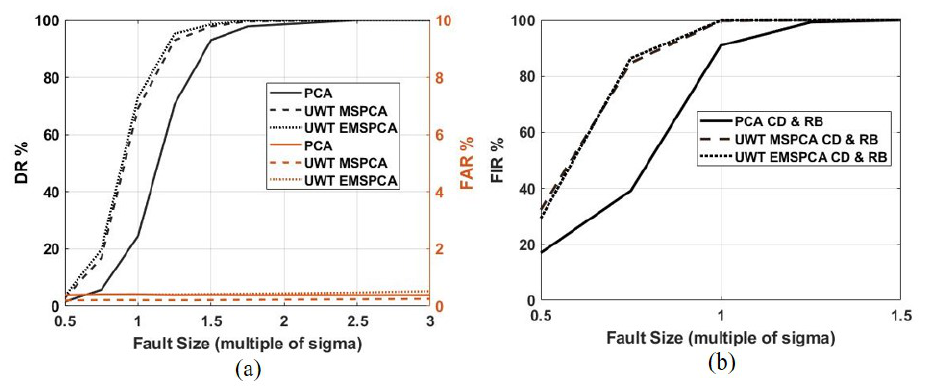
Figure 18. PCA, MSPCA, and EMSPCA detection and isolation performance for the pilot plant data across varying fault sizes and a fixed multiscale decomposition depth of 4; ( a ) detection rate (DR) and false alarm rate (FIR), ( b ) reconstruction-based fault isolation rate (RB FIR) and complete decomposition fault isolation rate (CD